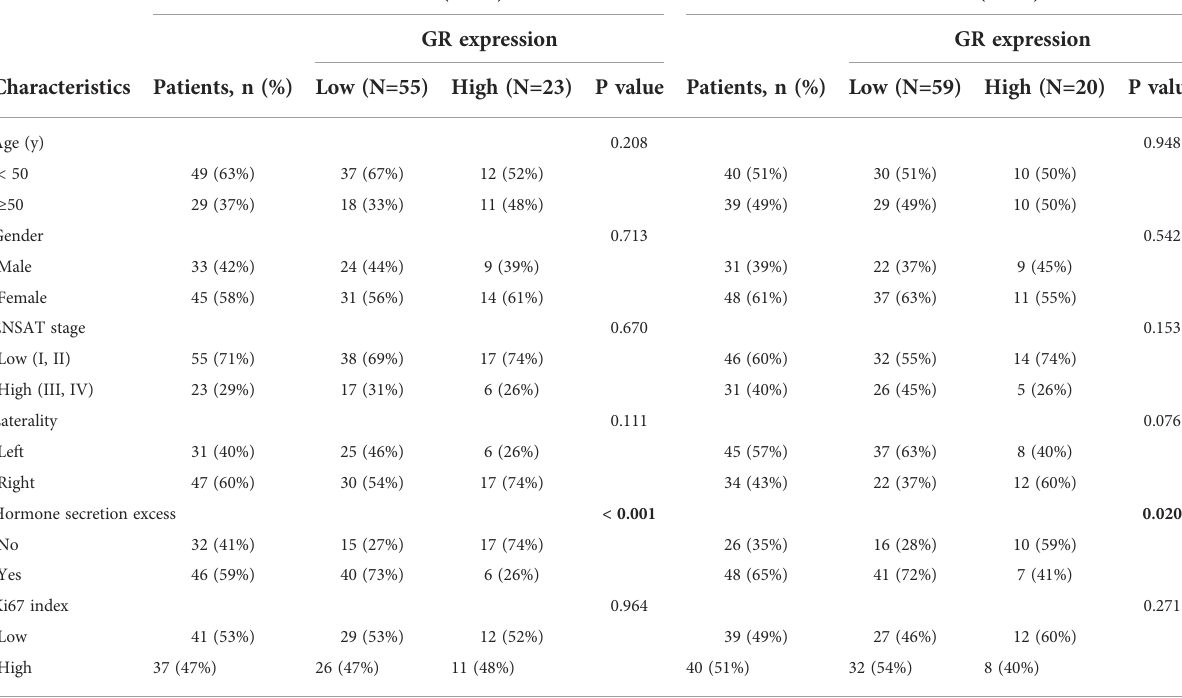
TABLE 1 Clinicopathological characteristics of ACC patients in WCH and TCGA cohort.